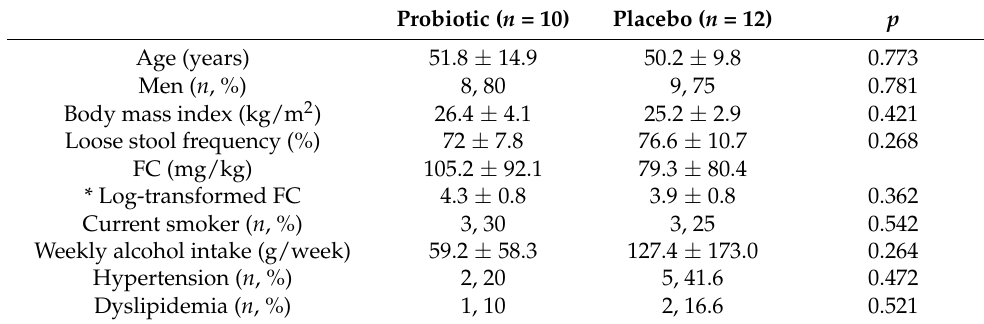
Table 1. Baseline characteristics of the study subjects.